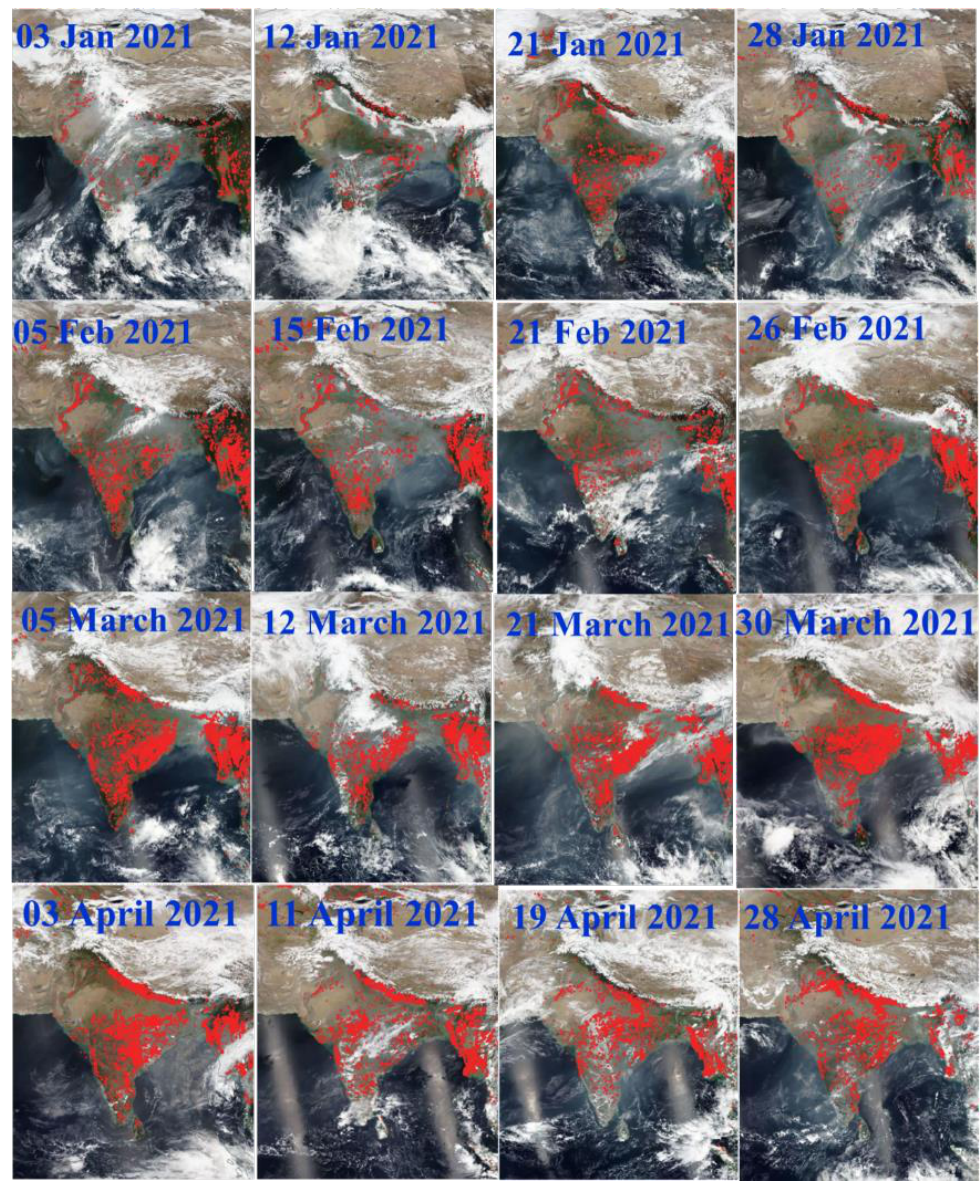
Figure 1. Forest fires detected from MODIS sensors of the Aqua and Terra Satellites during January to April 2021 on various days. The northern part of India is mostly affected by biomass burning.